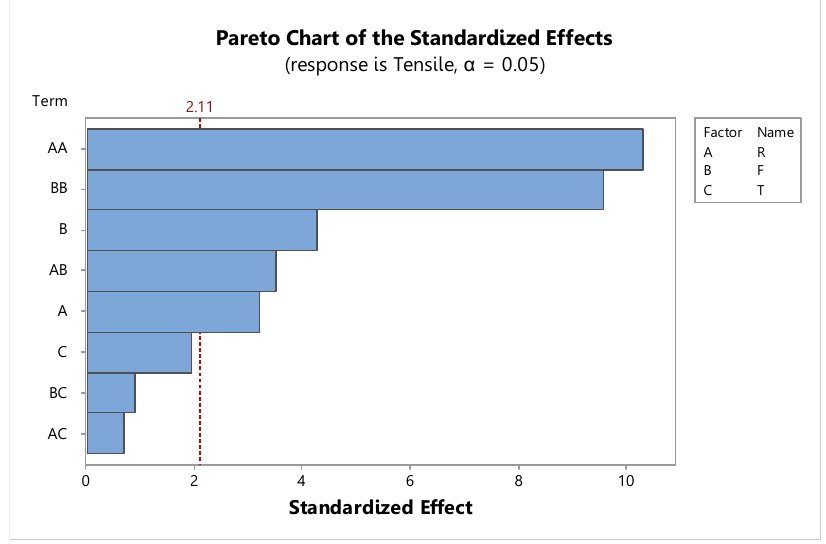
Figure 9. Pareto chart of the standardized effects for friction stir welding. Table 6. Analysis of variance for friction stir welding.